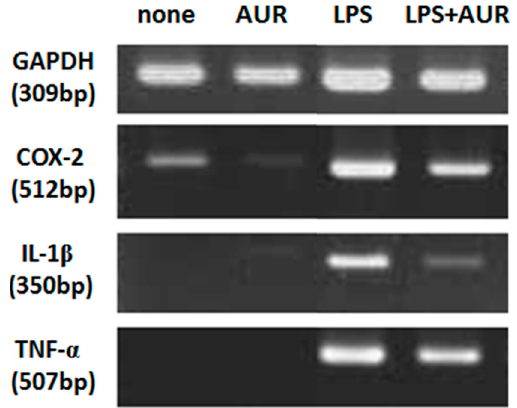
Figure 4. Effects of AUR on the expression of COX-2, IL-1 β , and TNF- α mRNAs in cultured astrocytes. Cells were not treated or were treated with AUR (25 µM) alone for 30 min, with LPS (10 ng/mL) alone for 4 h, or with AUR (25 µM) for 30 min and then with LPS (10 ng/mL) for 4 h. Representative densitometric patterns of COX-2, IL-1 β , TNF- α and GAPDH mRNAs bands were shown. Similar results were obtained from at least three independent experiments.